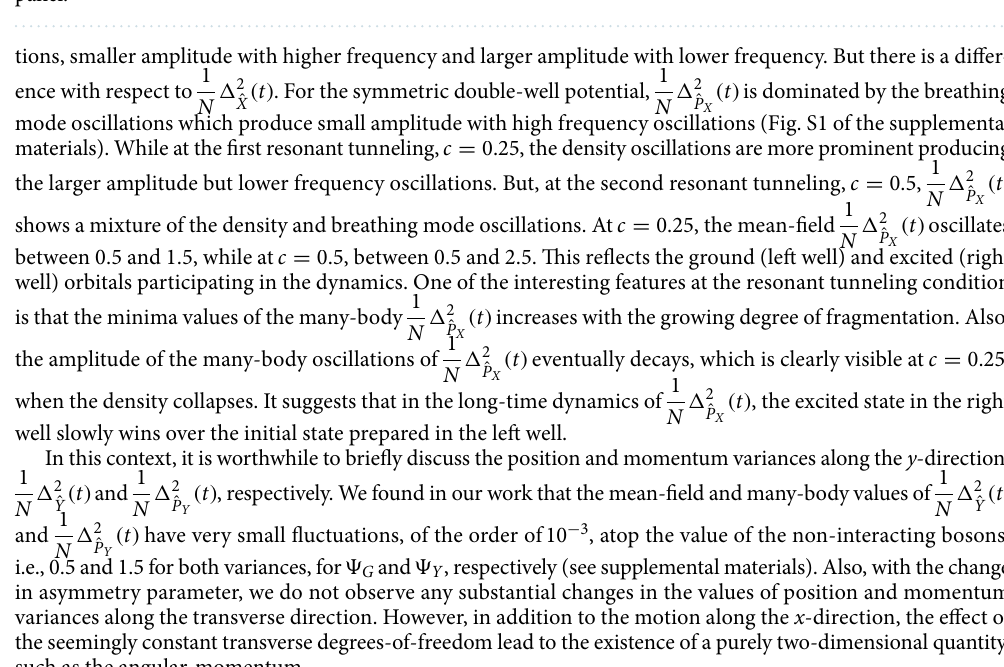
1 � 2 ( t ) at the N L Z ˆ 1 signifies the mean-field = 10 =